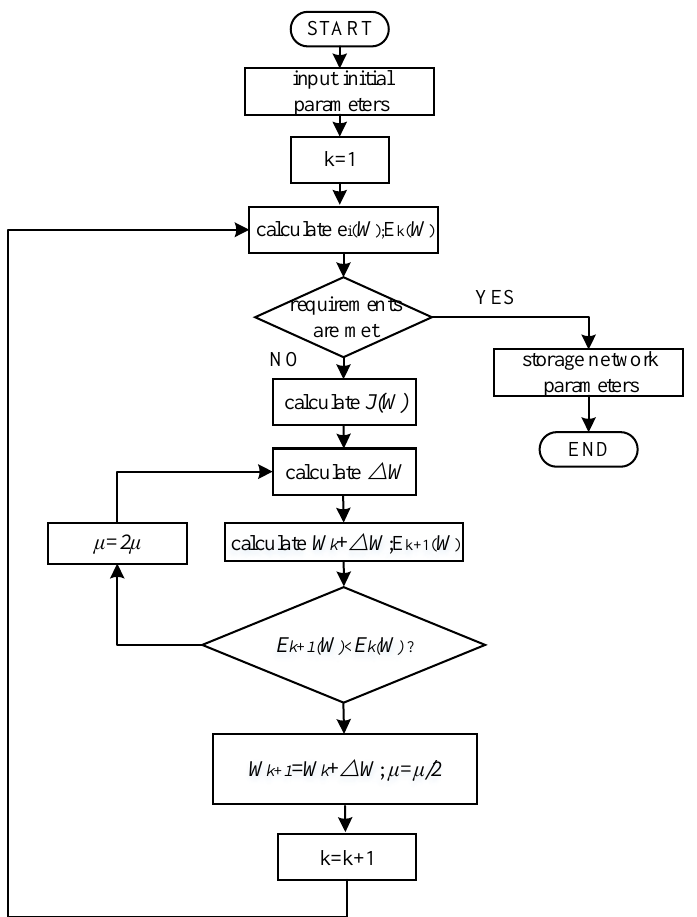
Figure 11. Levenberg-Marquardt algorithm flowchart.